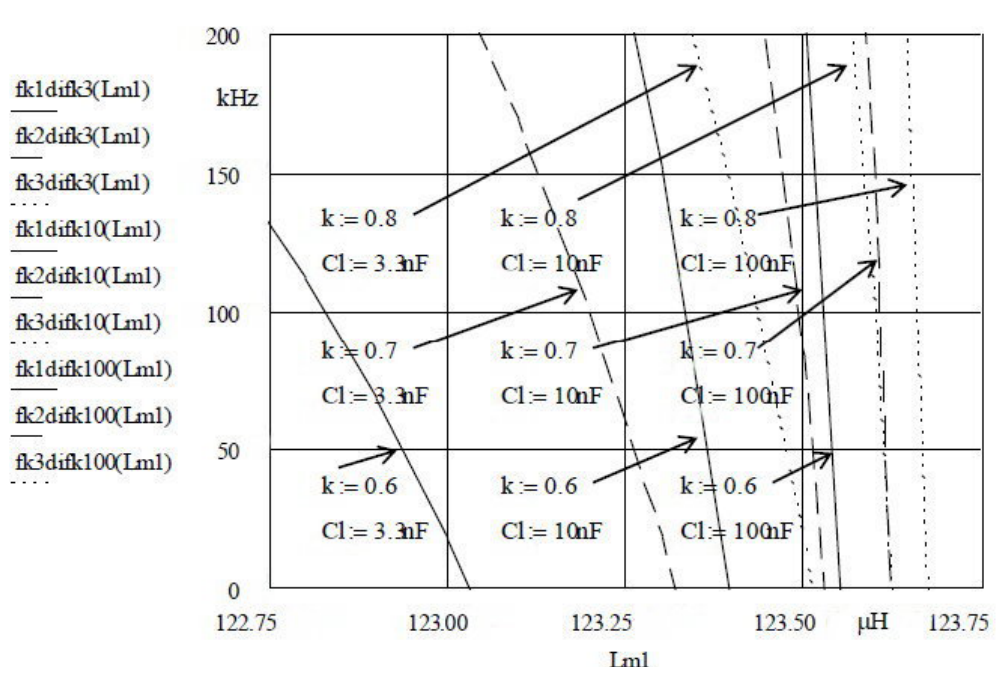
Figure 4. Quartz crystal frequency shift for k = 0.6, 0.7, 0.8 for L